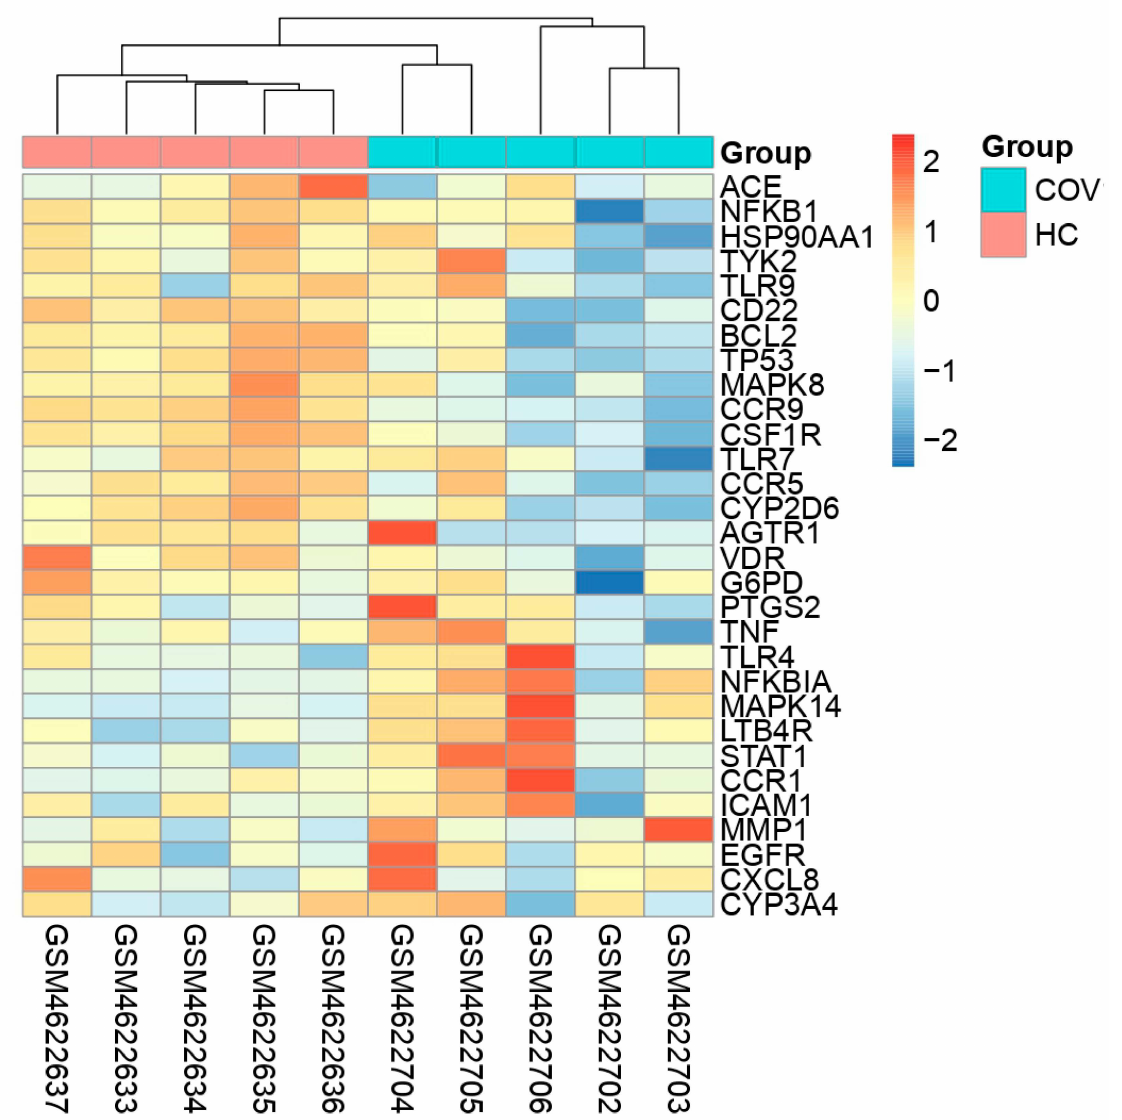
Figure 4. The heatmap plot denoting the 30 COVID-19-associated unique genes that are differentially regulated between the COVID-19-infected patients and healthy controls. The colored scale bar at the right indicates relative expression, where − 2 and 2 represent down and up-regulation, respec- tively. Red color—up-regulation; blue color—down-regulation; yellow color—stable/non-significant expression. COV—COVID-19; HC—Healthy